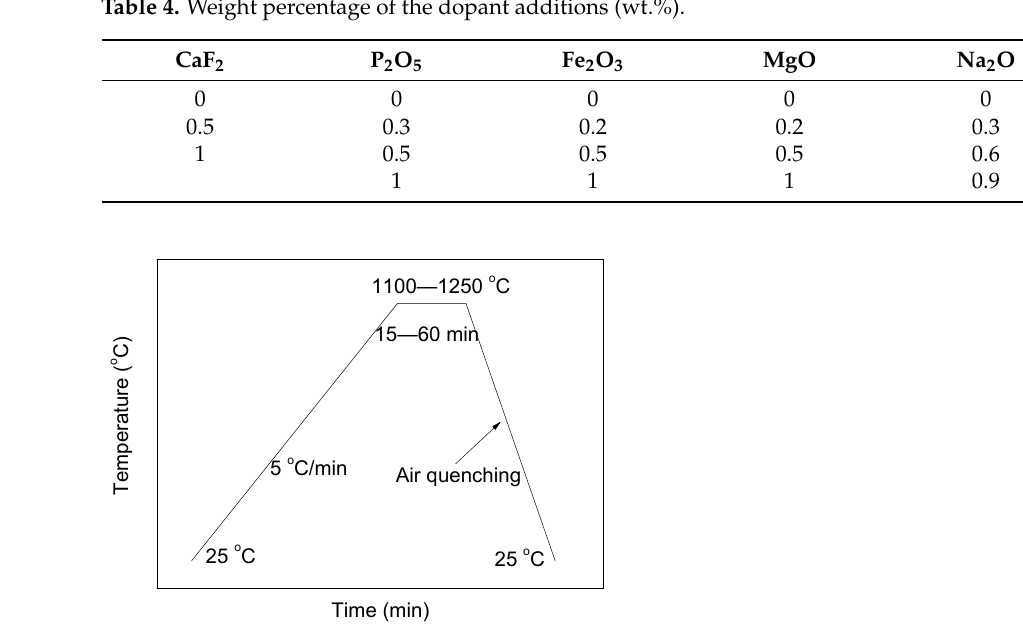
Table 3. Proportions of the raw materials (wt.%).